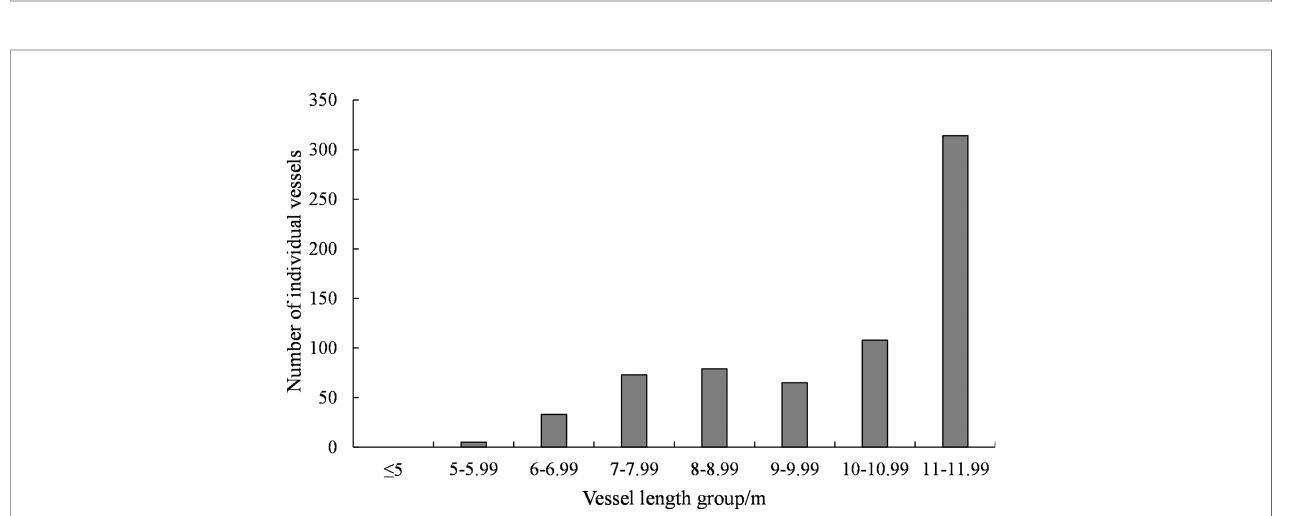
FIGURE 2 | Vessel construction material and gear types of small-scale fi sheries in Shengsi County, where black bar represents steel fi shing vessels, white bar represents wooden fi shing vessels.